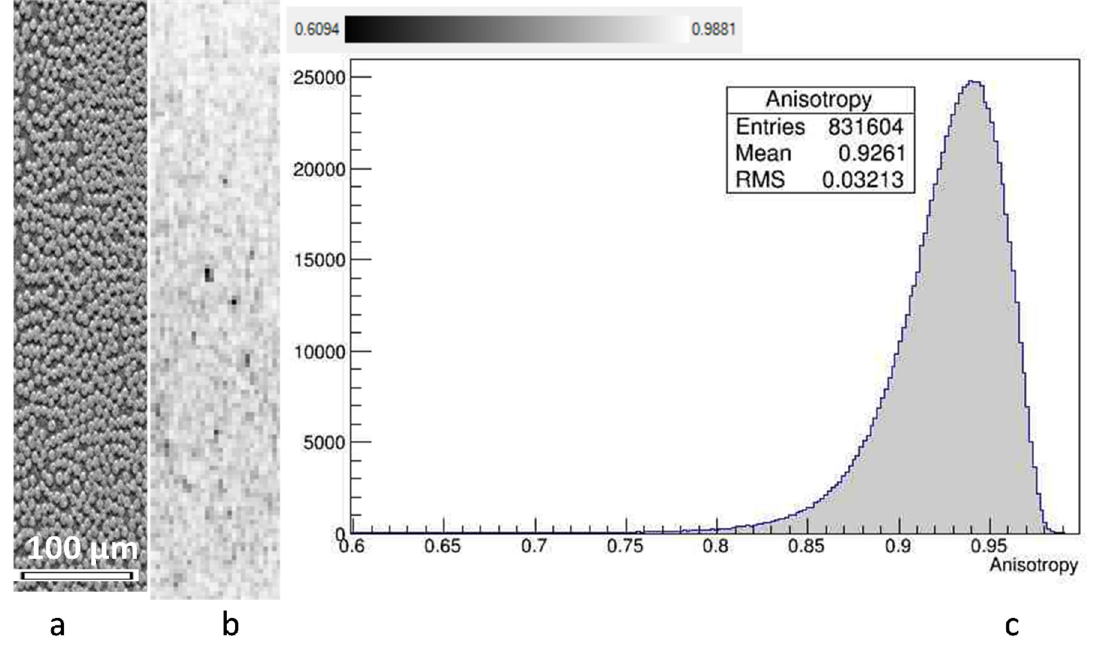
Figure 5. Anisotropy inside plies, a typical case (BSL11, ply − 45°): ( a ) a slice of the ROI; ( b ) distribu- tion of degree of anisotropy in voxels (with isotropy presented as black color and anisotropy as white color); ( c ) histogram of the degree of anisotropy.